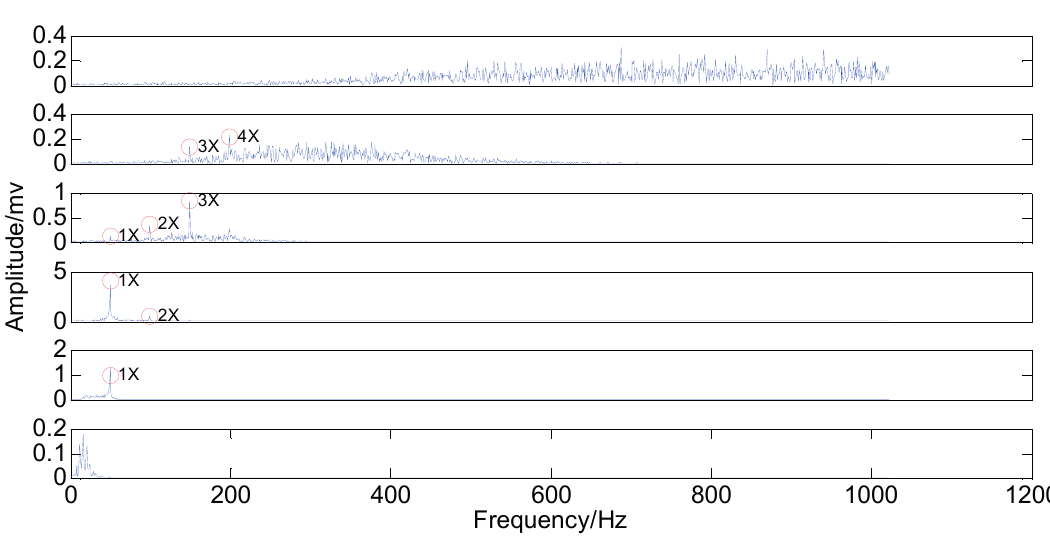
Figure 17. Optimized IMFs in the time-domain.